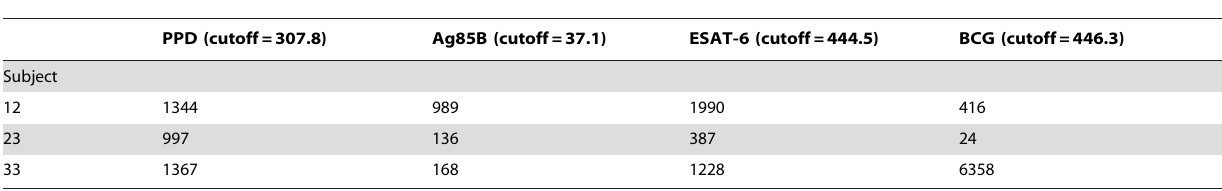
Table 3. Analysis of Extreme IFN- c /IL-17 Responses.